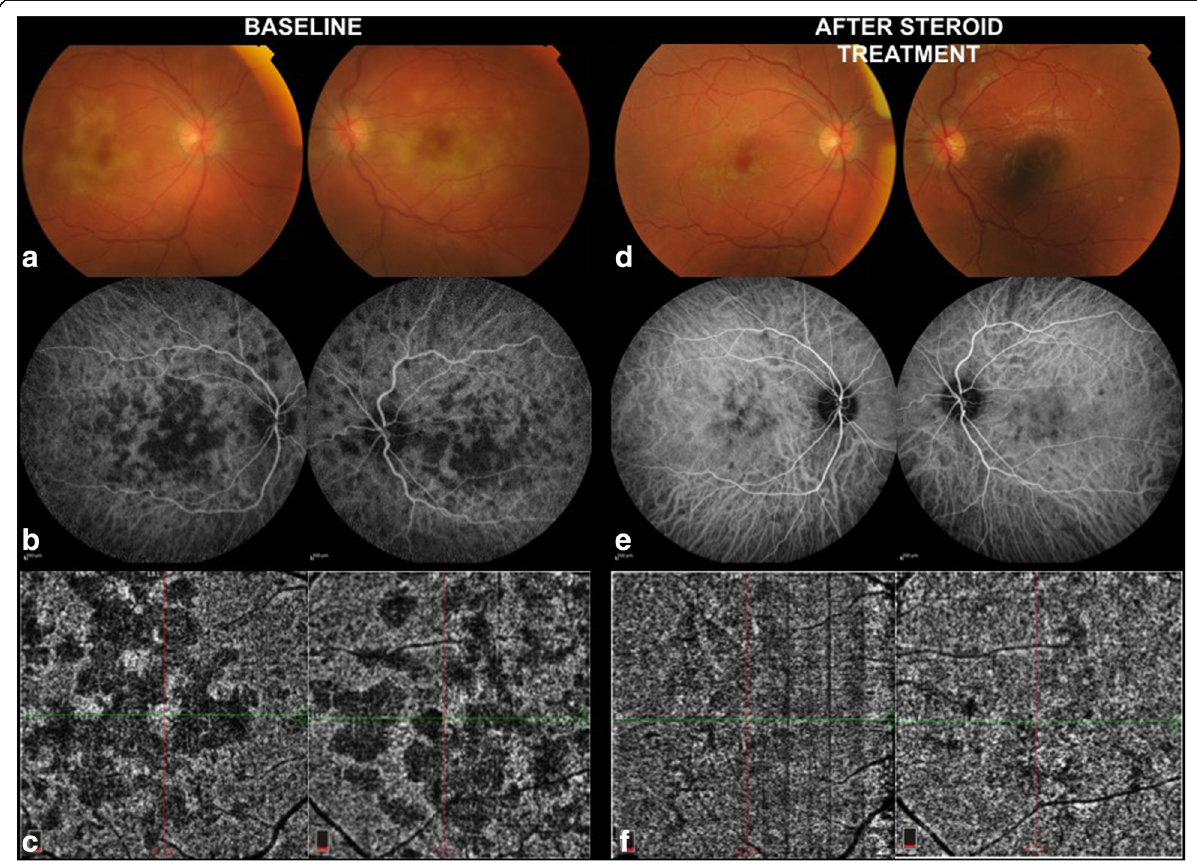
Fig. 3 Right and left eye of a patient with APMPPE. At baseline, the creamy-white lesions ( a ) correspond to hypofluorescent areas on ICGA ( b ). These prove to be true areas of choriocapillaris ischemia on OCTA ( c ) that precisely co-localize with the shape and pattern of the ICGA lesions. After 3 weeks of oral steroids, the lesions disappear on fundus photography ( d ). Mild choroidal hypoperfusion is still detected in ICGA ( e ) and OCTA ( f ) but with